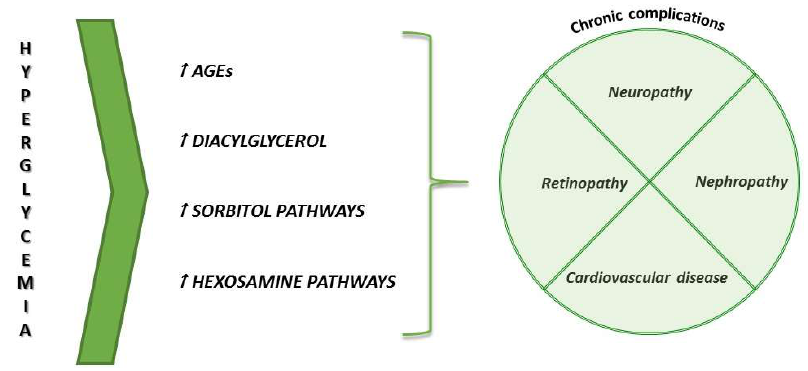
Figure 1. Summary of the theories underlying long-term complications of diabetes.